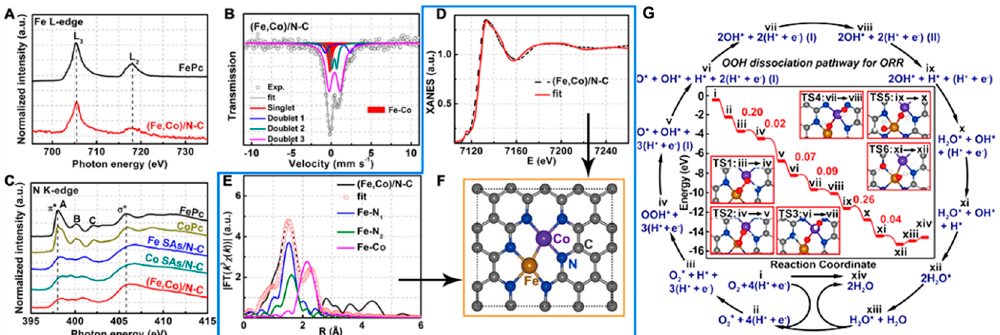
Figure 17. ( a ) XANES spectra of Fe L-edge of the prepared (Fe,Co) / N–C and FePc. ( b ) Fe Mössbauer transmission spectra measured at 298 K for (Fe,Co) / N–C, and fittings with spectral components. ( c ) N K-edge XAS spectra of Fe SAs / N–C, Co SAs / N–C, and (Fe,Co) / N–C. ( d ) Comparison between K-edge XANES experimental spectrum of (Fe,Co) / N–C (black dashed line) and simulated spectrum obtained with depicted structure (solid red line). ( e ) Corresponding Fe K-edge EXAFS fittings of (Fe,Co) / N–C. ( f ) Hypothetical structures of Fe–Co dual sites. ( g ) Energies of intermediates and transition states in mechanism of ORR at (Fe,Co) / N–C from density functional theory calculation (DFT), reproduced with permission [52]. Copyright American Chemical Society, 2017.